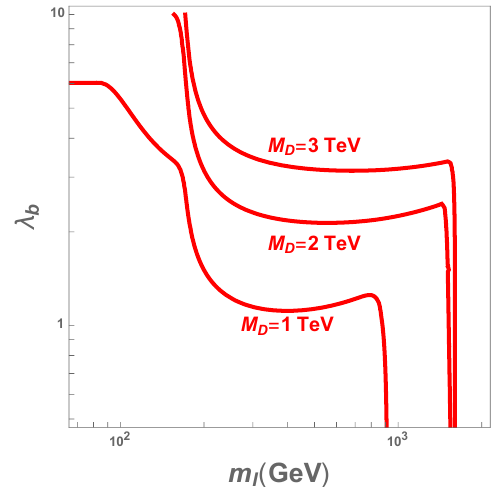
Figure 11 . A plot of (cid:21) b as a function of m I to give constant (cid:10) DM h 2 = 0 : 1199 for three di(cid:11)erent values of M D : M D = 1 ; 2 ; 3 TeV. The rest of the (cid:12)xed parameters can be found in the